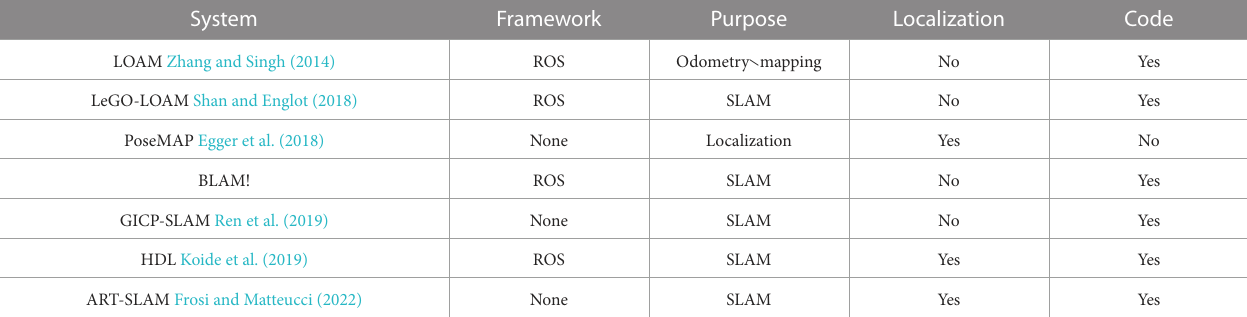
TABLE1 Summaryofthe3Dlocalizationandmappingapproaches.MethodsarealsocomparedbasedonwhethertheyadopttheRobotOperatingSystem(ROS) Quigley et